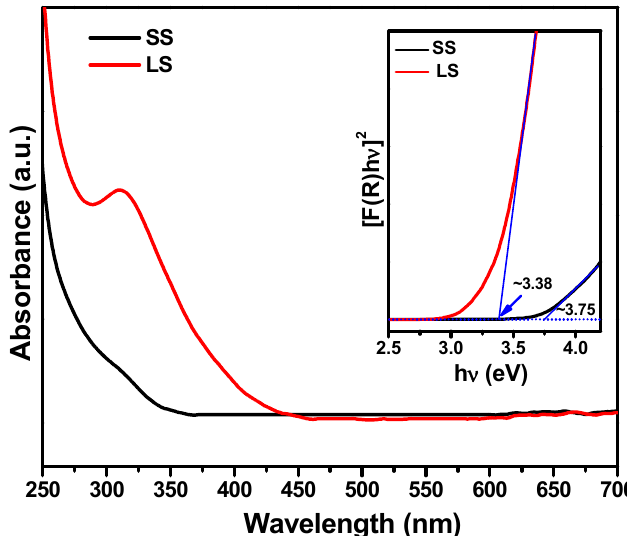
Figure 6. UV–Vis absorption spectra measured by the diffuse reflectance method. Inset shows an estimation of the band gap energy of the SS and LS samples.